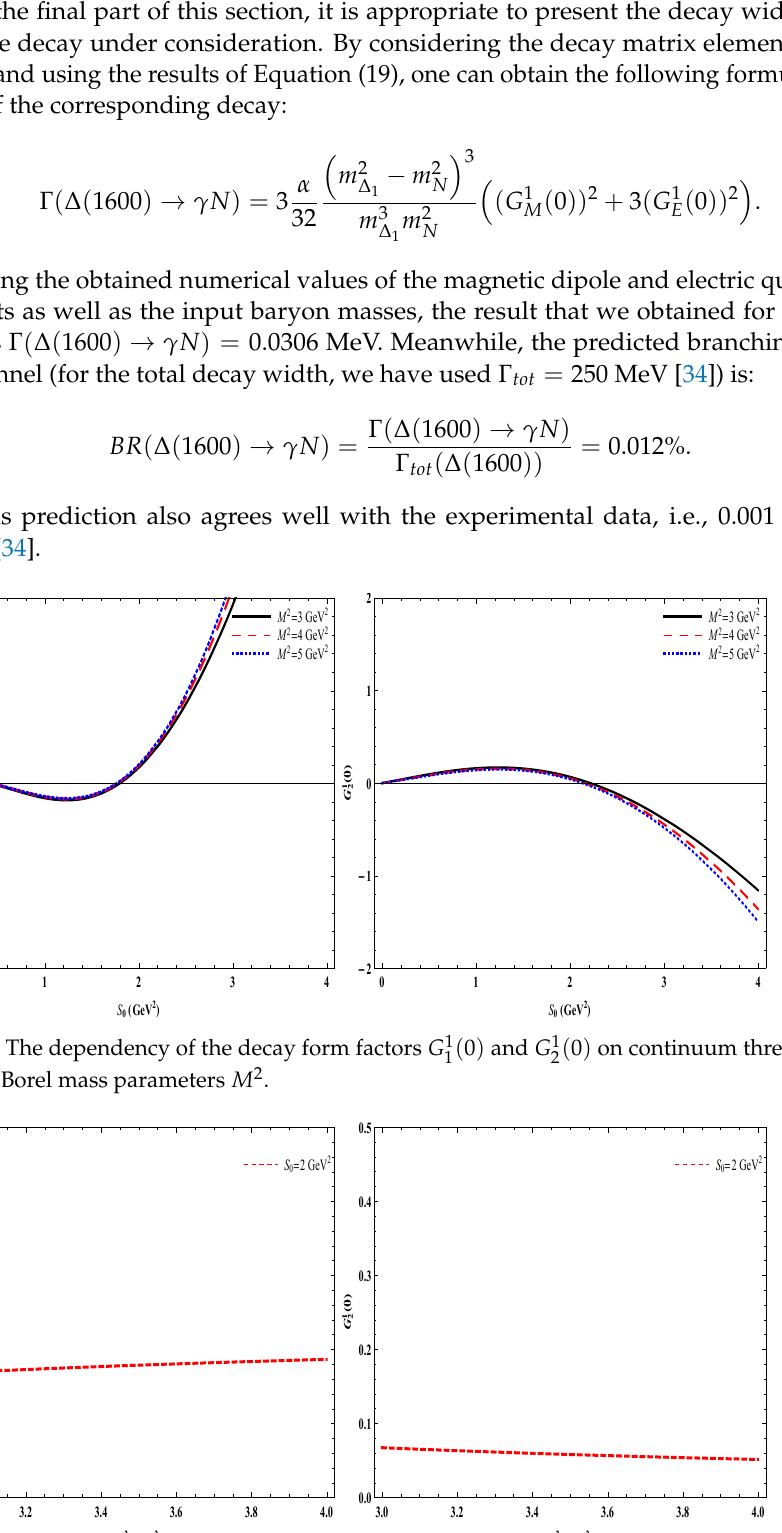
( 0 ) and G 1 ( 0 ) on the Borel mass parameter 2 1